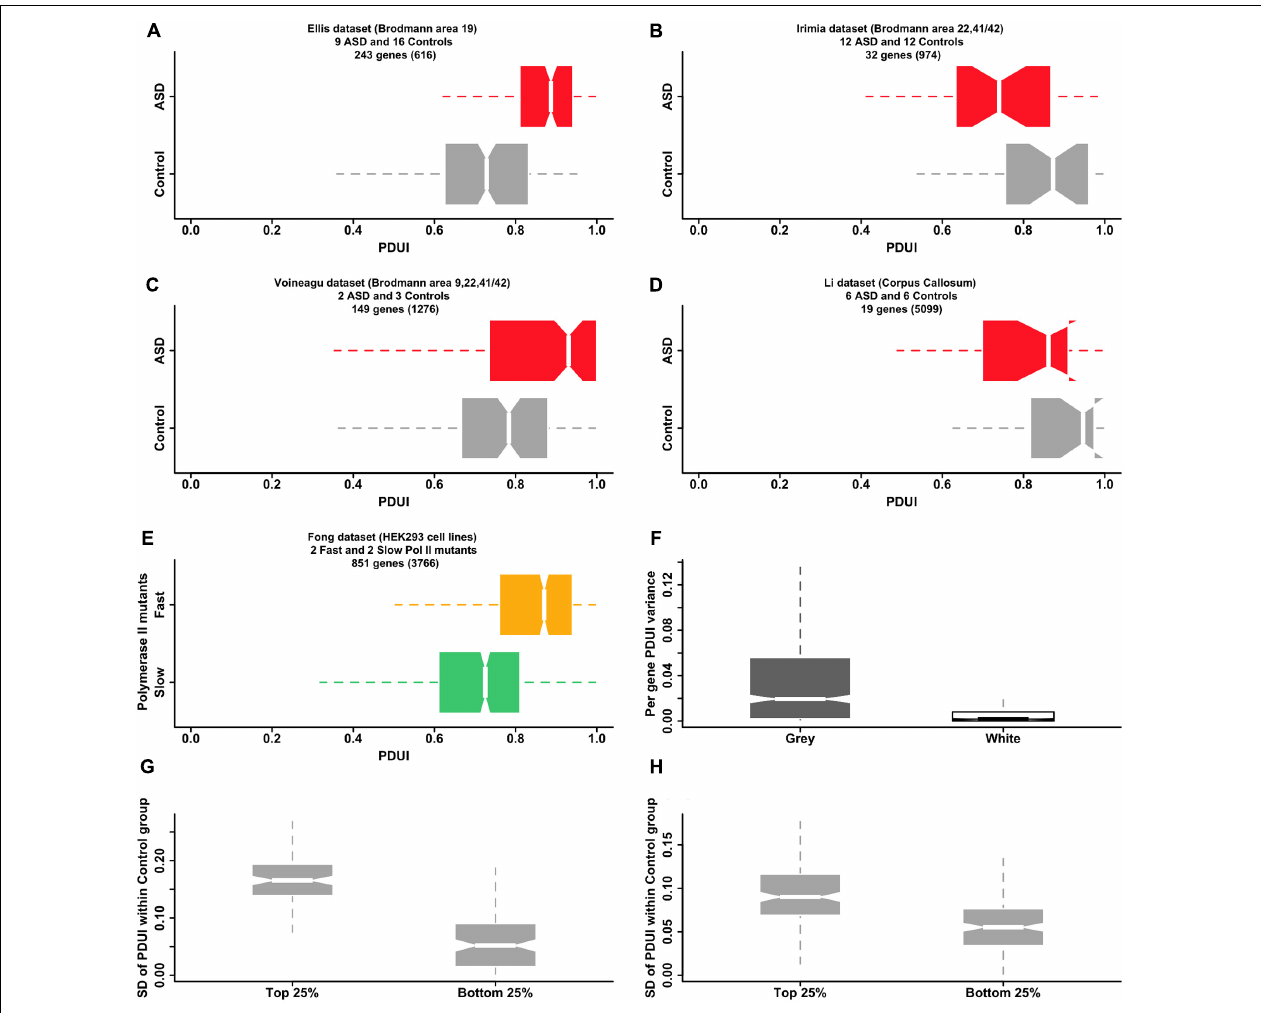
FIGURE 2 | Publicly available transcriptomic data supports a model of APA dysregulation in the ASD brain. (A–D) RNA-seq data for ASD and control post-mortem brain samples from four publicly available datasets show statistically significant differential APA events, as revealed by the software DaPars-v.0.9 (Masamha et al., 2014). Box-and-whisker plots depict the distribution of Percentage Distal poly(A) site Usage Index (PDUI) values within a set of samples, grouped by condition (gray:control; red:ASD). The PDUI value is calculated for each gene passing the coverage thresholds of DaPars (number of genes quoted in brackets) and is a measure of the preference of using the distal over the proximal poly(A) site (PDUI is 1, if all reads are assigned to the distal site and 0, if all reads are assigned to the proximal site). Only statistically significant events (adjusted p -value < 0.05, Fisher exact test) are included in the box-and-whisker plots. There is a statistically significant preference for longer 3 (cid:48) UTRs (larger PDUI values) in the ASD group as compared with the control group in both the Ellis and Voineagu datasets ( p- value < 2.2e-16 and p-value = 6.2e-12 respectively for one-sided KS test between control and ASD group mean PDUIs). The Irimia and Li datasets show the opposite trend ( p -values are 0.0018 and 0.075 correspondingly) but much smaller numbers of differential events have been identified in these datasets (see also F of this figure). (E) “Fast” mutants of Pol II affect the selection of the poly-adenylation site in a way reminiscent of the effects observed in ASD brain samples. Box-and-whisker plots show the distribution of PDUI values for genes showing differential APA events between “fast” (orange) and “slow” (green) mutants of Pol II (data from (Fong et al., 2014)). There is a clear preference for longer 3 (cid:48) UTRs (larger PDUI values) in the case of the fast mutant ( p -value = 2.9e-06, KS test), reminiscent of the ASD group in the Ellis and Voineagu datasets (A,C) . (F) Samples originating from brain gray matter display larger variations in PDUI values compared with samples from white matter ( p -value < 2.2e-16; unpaired one-sided Wilcoxon rank-sum test), offering an explanation for why we find so few differential APA events in the Li dataset (which originates from corpus callosum , an area of the brain dominated by white matter). The box-and-whisker plots display the range of PDUI variances calculated by DaPars for 1038 genes from the Mills dataset. The dataset originates from (Mills et al., 2015) and comprises three samples derived from white matter and three samples derived from gray matter. The plot suggests that samples from white matter can be expected to show relatively little variation in their PDUI values. (G,H) Genes associated with greater variance in APA site selection among neurotypical subjects also show larger PDUI group mean differences between ASD and control subjects. Box-and-whiskers plots of the standard deviation of PDUI value within the control group are shown for genes with the largest difference in APA site selection between ASD and control groups (top 25% of the distribution of absolute values of PDUI group mean differences) and genes with the smallest difference (bottom 25% of the same distribution). Plots are shown for the Ellis (G) and Irimia (H) datasets but plots for the Voineagu and Li datasets are similar (not shown). Genes with large between-group PDUI differences show much larger variability in the PDUI value within the control group in both the Ellis and Irimia datasets ( p -value = < 2.2e-16 for both datasets; unpaired, one-sided Wilcoxon rank-sum test). All plots were generated using the R statistical software suite. The boxplot whiskers extend in all cases to the most extreme data point, which lies at no more than 1.5 times the interquartile range from the